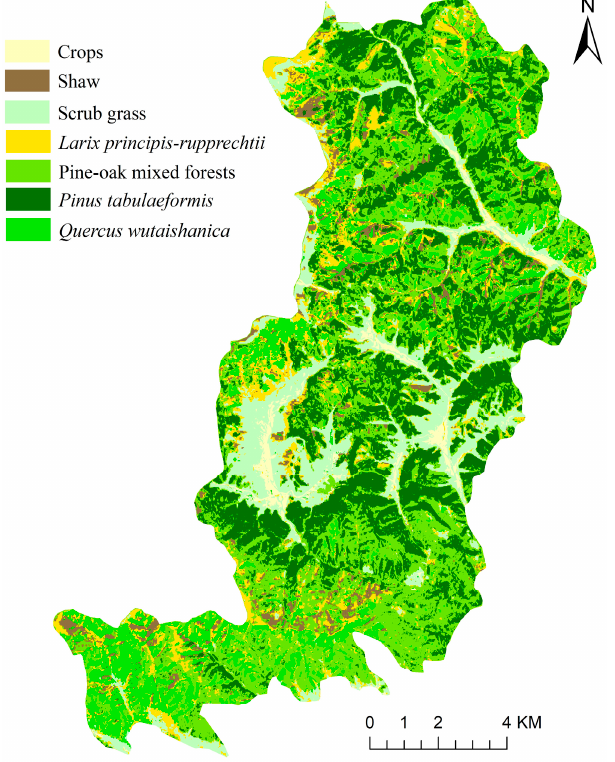
Figure 7. Classification of main vegetation types in the